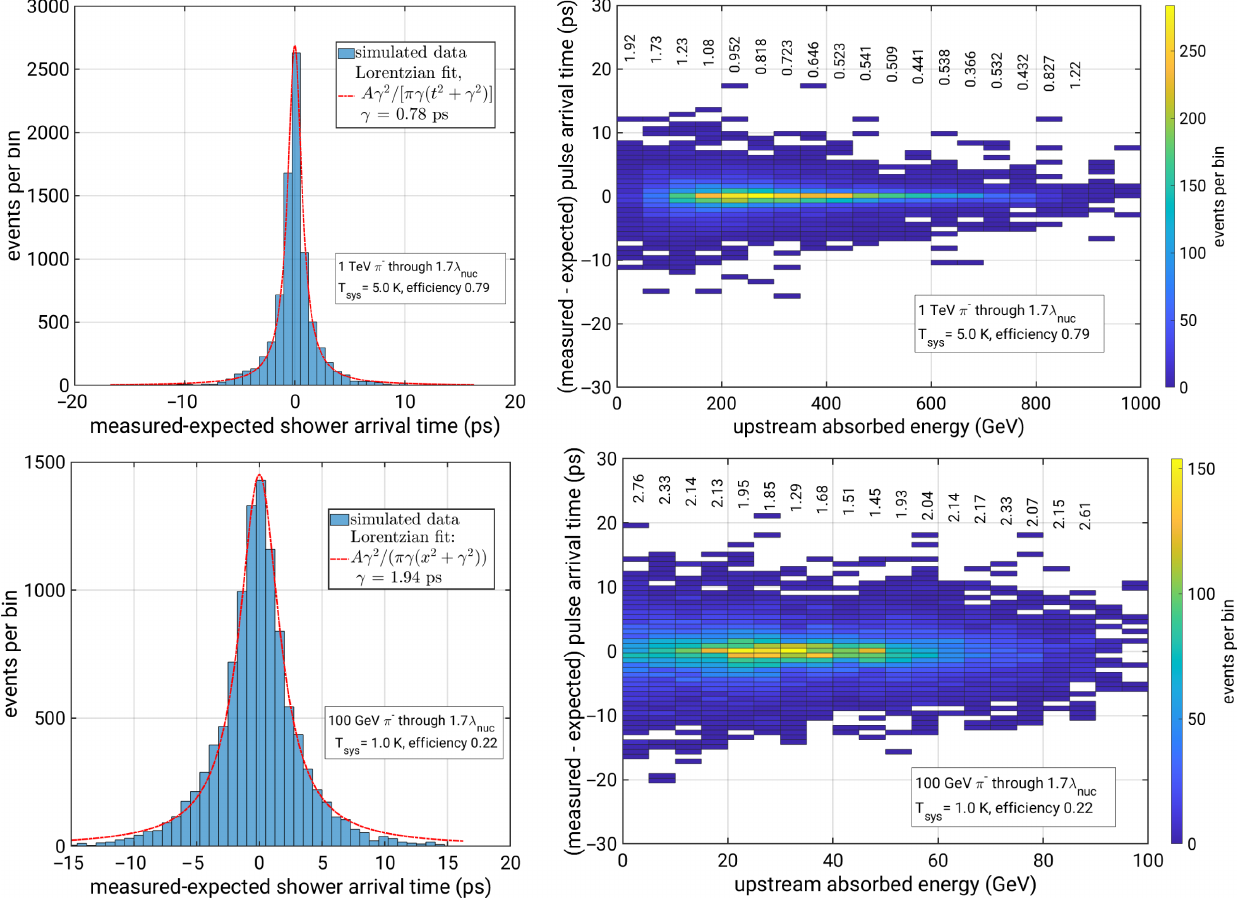
FIG. 27. Distributions of all times and time vs absorbed energy prior to the timing plane, for charged pions at 1 TeVand 100 GeV. Here our timing plane is between the forward EMCAL and HCAL, with about 1.7 nuclear interaction lengths of material ahead of